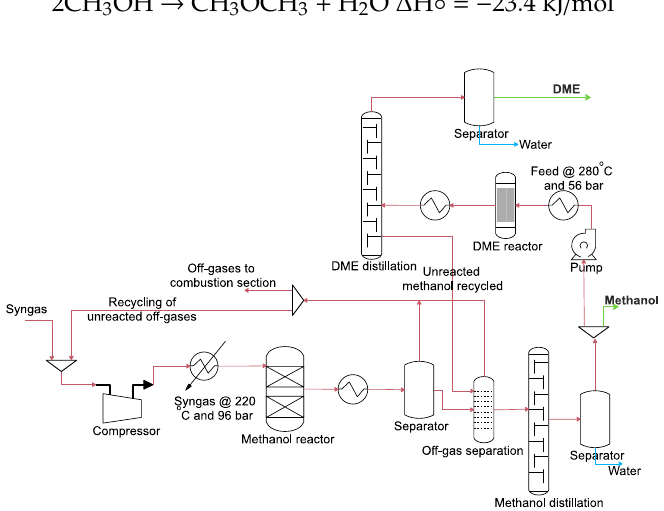
Figure 6. Process flow diagram of methanol and DME synthesis from syngas produced from waste gasification.